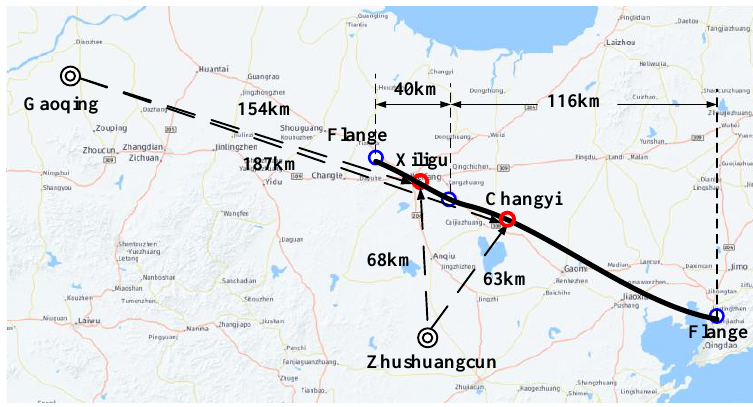
Figure 1. Positions of grounding electrodes and monitoring sites.